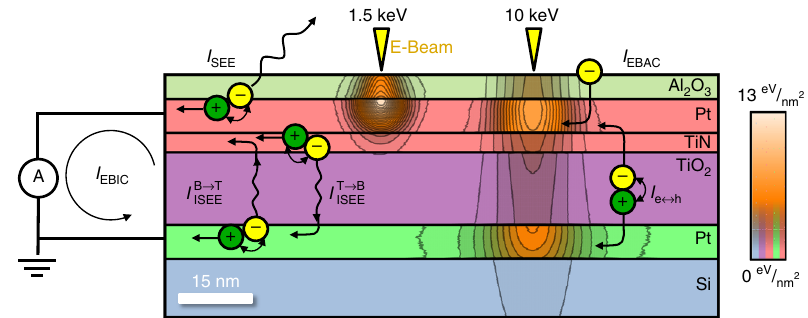
Fig. 2 Depiction of device beam interaction. Monte Carlo-simulated absorption in a multi-layer ReRAM device at both 1.5 keV incident beam and 10 keV incident beam. Absorption in different layers can result in the different depicted currents including the secondary electron current ( I SEE ), the electron beam absorbed current ( I EBAC ), the electron – hole pair current ( I e $ h ), and the internal secondary electron currents from top to bottom ð I T ! B ð I B ! T Þ . These all sum to create the measured electron beam-induced current ð I ISEE intermediate intensity (orange), and zero intensity (transparent revealing diagram coloring of corresponding